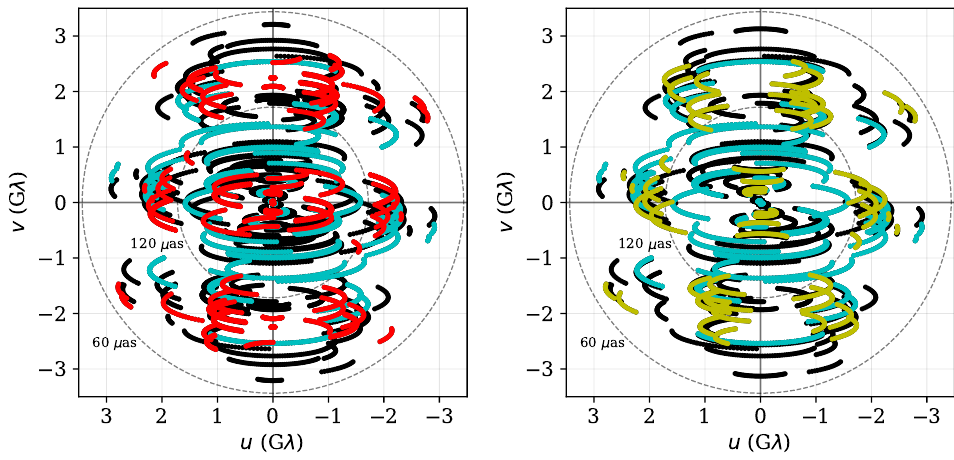
Figure 4. Coverage at 86GHz ( u , v ) ( bottom row ) and signal-to-noise ratio versus ( u , v ) distance ( top row ) for the two ngEHT array configurations, as viewed from M87. The left panels show baselines between EHT stations in cyan, baselines between ngEHTa stations in red, and baselines between ngEHTa and EHT stations in black. The right panels show baselines between EHT stations in cyan, baselines between ngEHTb stations in yellow, and baselines between ngEHTb and EHT stations in black. The horizontal dashed and dotted lines in the top panels show the 86GHz S/N levels necessary to achieve 90% phase coherence at 230 and 345GHz,